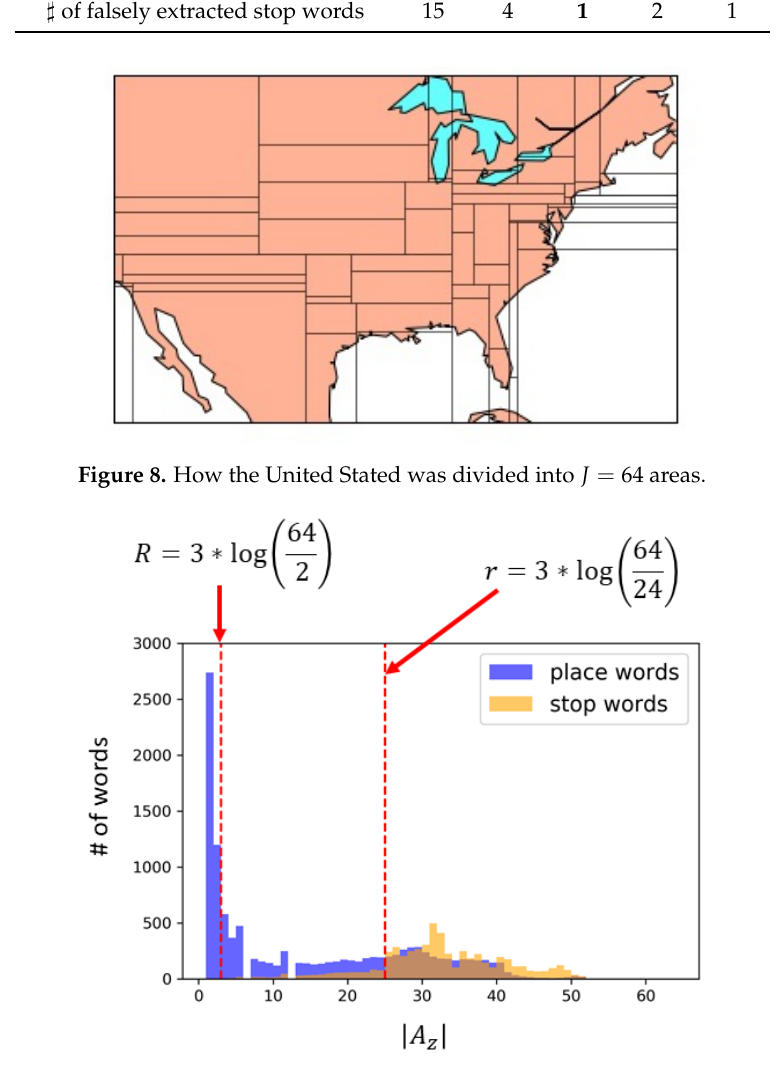
Figure 9. Histogram of the number of areas in which place names and stop words were used when f mode z = θ (= 3 ) . Approximately 80% of the place names and less than 1% of stop words were used in fewer than two areas when f mode z = 3. On the other hand, approximately 70% of the stop words and 2% of the place names were used in more than 24 areas when f mode z = 3. The dashed red lines show these thresholds corresponding to R and r